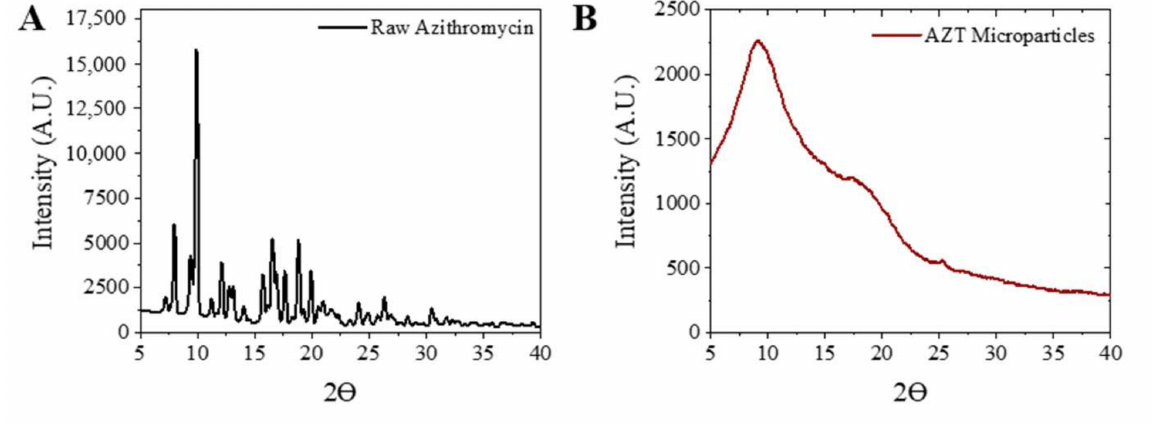
Figure 3. X-ray diffraction patterns: ( A ) raw azithromycin; ( B ) azithromycin